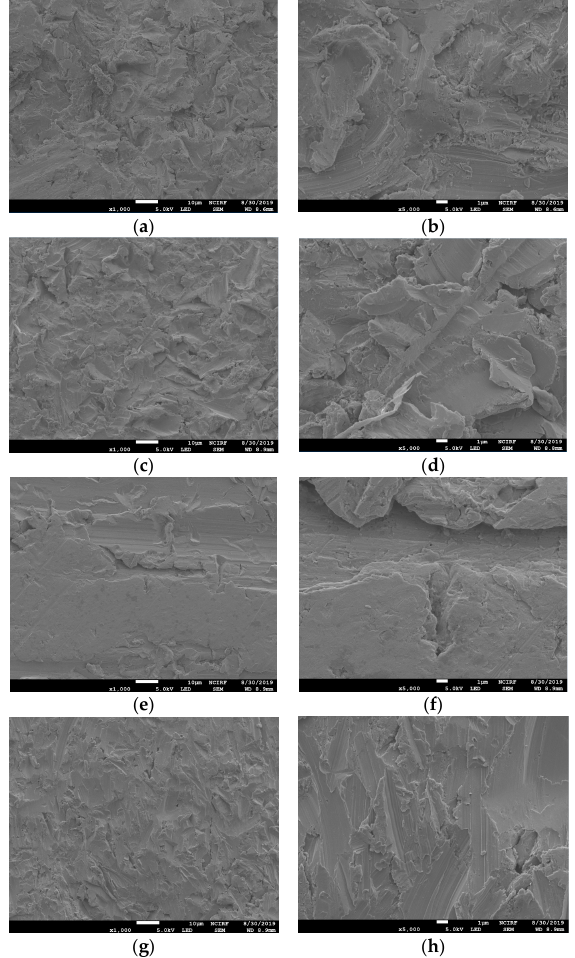
Figure 1. Scanning electron microscope (SEM) images of the surfaces of non-polished Ni-Cr and Co-Cr disks. Ni-Cr group: each row, left to right, original magnification ( a ) 1000 × , ( b ) 5000 × . Co-Cr (casting) group: ( c ) 1000 × , ( d ) 5000 × . Co-Cr (milling) group: ( e ) 1000 × , ( f ) 5000 × . Co-Cr (3D) group: ( g ) 1000 × , ( h ) 5000 ×